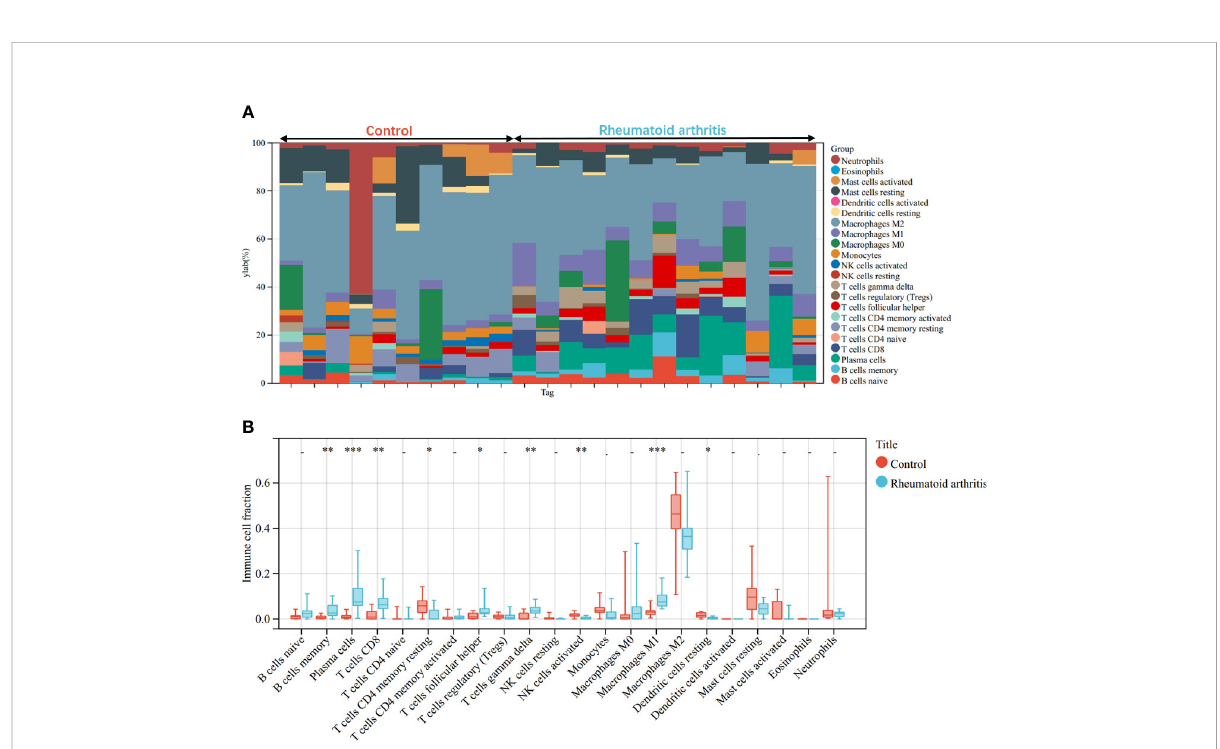
FIGURE 11 Immune cell in fi ltration mode in RA. (A) The relative percentage of 22 immune cell subpopulations out of 23 samples from the GSE55457. (B) The ratio of 22 immune cells between RA and control in GSE55457. *p < 0.05; **p < 0.01; ***p <